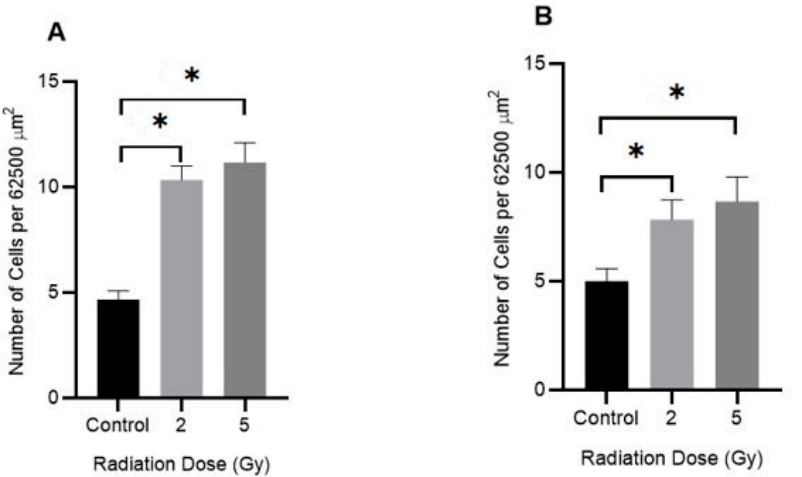
Figure 8. E ff ect of IR on the adhesion of human cancer cells in vitro. ( A ) DU145 (prostate) and ( B ) A549 (lung) cancer cells were exposed to either 2 or 5 Gy (6 MV X-rays) and after 24 h the cells were trypsinised and plated in 6-well plates. After 4 h, the number of adhered cells in a 62,500 µ m2 area were counted. Results are expressed as mean ± SEM of 3 replicates. Significance of di ff erent IR doses on cell adherence is shown as * p < 0.05.